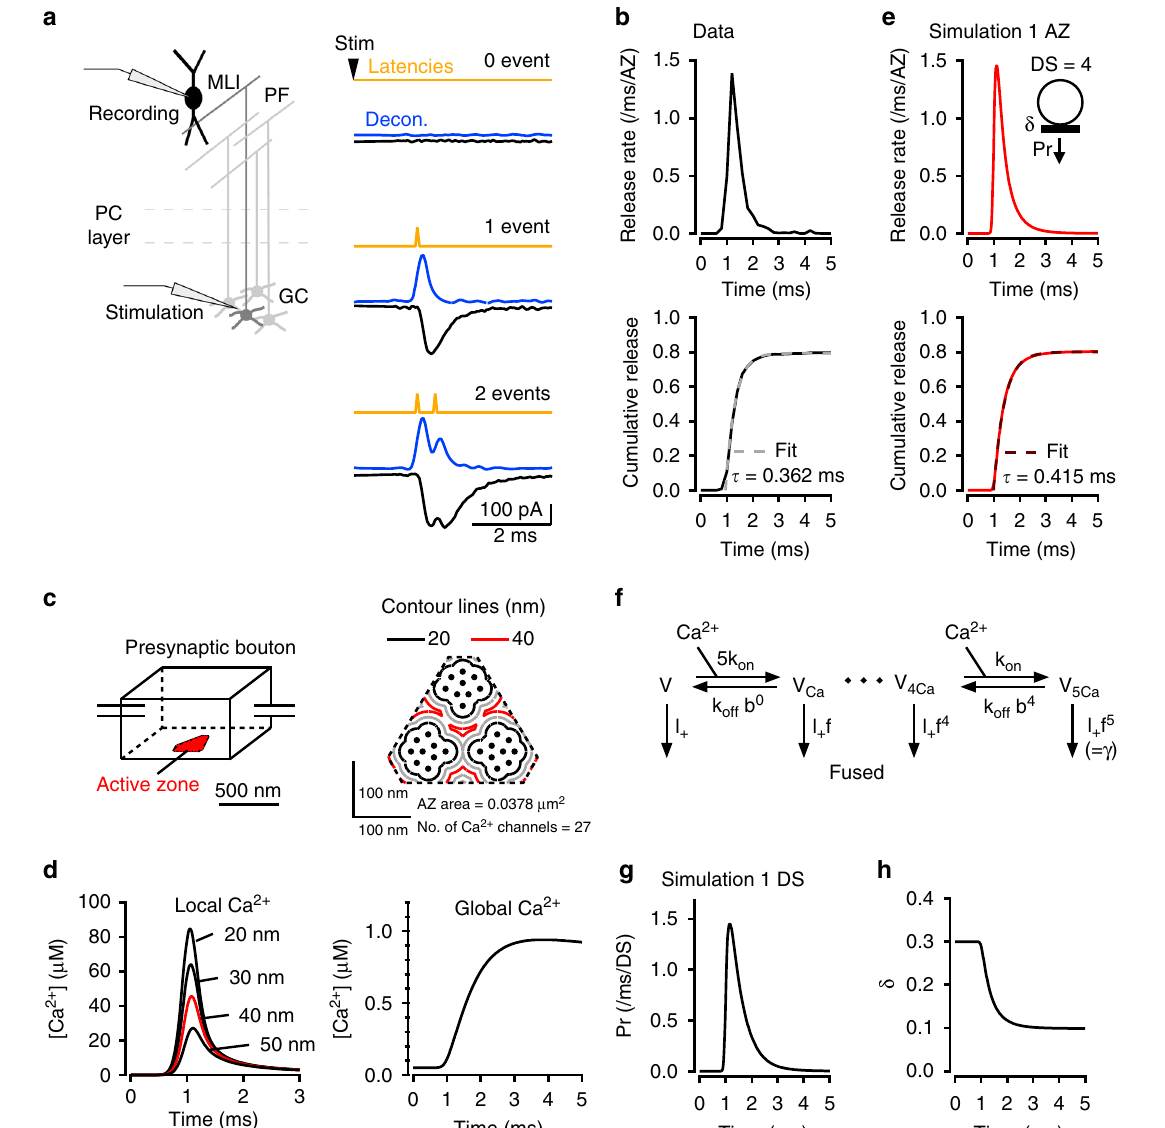
Fig. 1 Fast latency distribution following single AP stimulation. a Schematics of recording conditions. Representative recordings from a simple PF-MLI synapse, showing individual EPSC responses (black) to presynaptic AP stimuli (stim), deconvolved traces using quantal EPSC as kernel (blue), and calculated latencies obtained by analysis of deconvolved traces (yellow). b Upper panel: Release rate for individual simple synapses (average from n = 17 synapses). Lower panel: Corresponding cumulative histogram, with superimposed exponential fi t. c Schematic representation of presynaptic PF bouton, as used for the calculation of [Ca 2 + ] pro fi les. The AZ has a roughly triangular shape and contains three clusters of VGCCs. SV release occurs near contour lines at a 40 nm distance from VGCC cluster edges (red). d Calculation of [Ca 2 + ] pro fi les averaged over the contour lines shown in c (left; max. [Ca 2 + ] = 45.6 μ M at 40 nm distance shown in red), as well as in more distant locations (>100 nm: right; max. [Ca 2 + ] = 0.9 μ M). e Based on the local [Ca 2 + ] pro fi le at 40 nm distance, the calculated release rate per simple synapse (with 4 docking sites, an initial docking site occupancy of 0.3, and no replenishment) peaks near 1.5 ms − 1 (or 1500 s − 1 ; upper panel), with a cumulated release probability near 0.8 (lower panel). f Allosteric model used for estimation